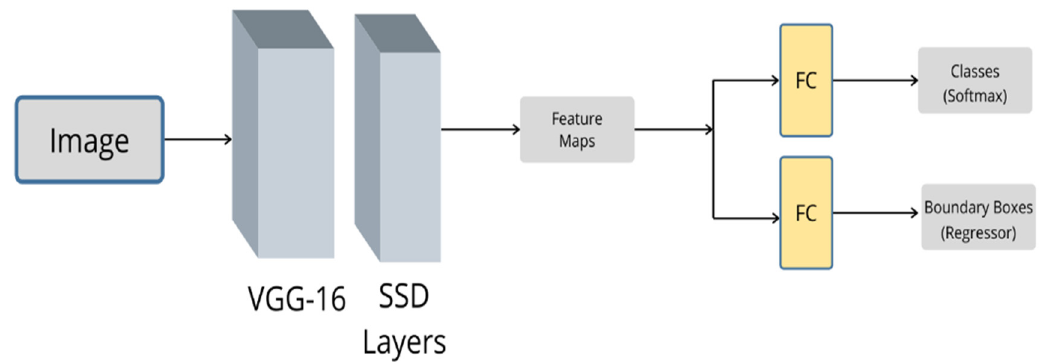
Figure 15. The architecture of the SSD algorithm. The CNN Network is VGG-16.